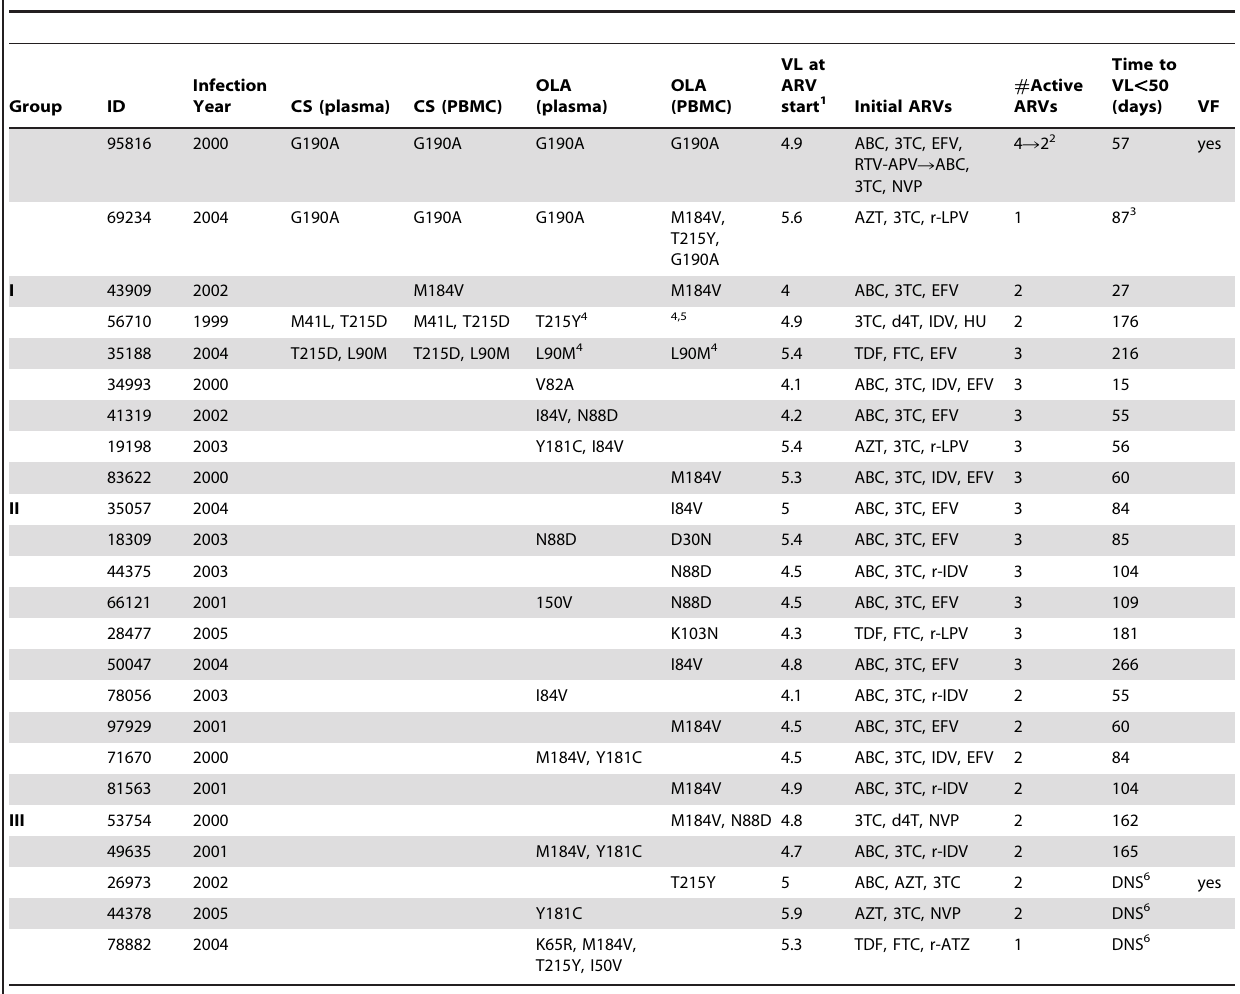
Table 3. HIV-1 drug resistance detected by consensus sequencing and OLA in ARV-naı¨ve subjects and virologic response to ARV